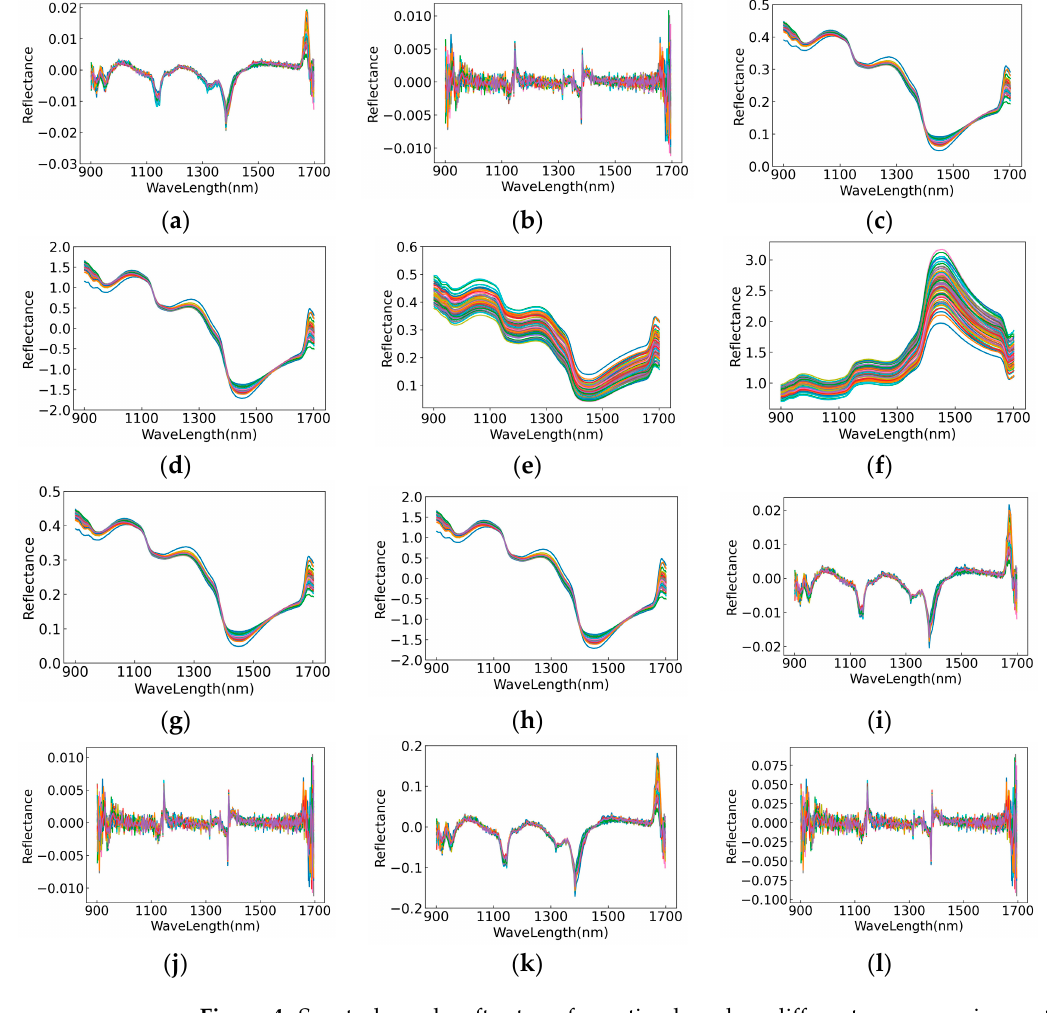
Figure 4. Spectral graphs after transformation based on different preprocessing methods. ( a ) FD,